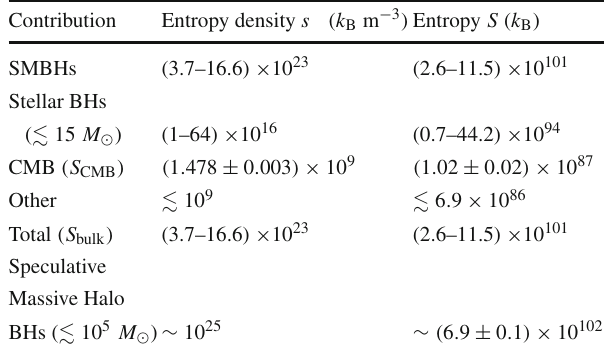
Table 1 Entropy of the observable Universe